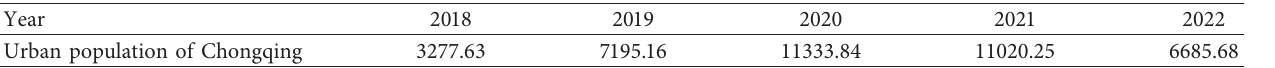
Figure 6: Simulated and forecasted data of the two models. (a) Simulated data of the LPGM (1, 1). (b) Simulated data of the LPGMWBO. Table 12: Predicted urban population data for Chongqing, China, from 2018 to 2022 (unit: ten thousand).